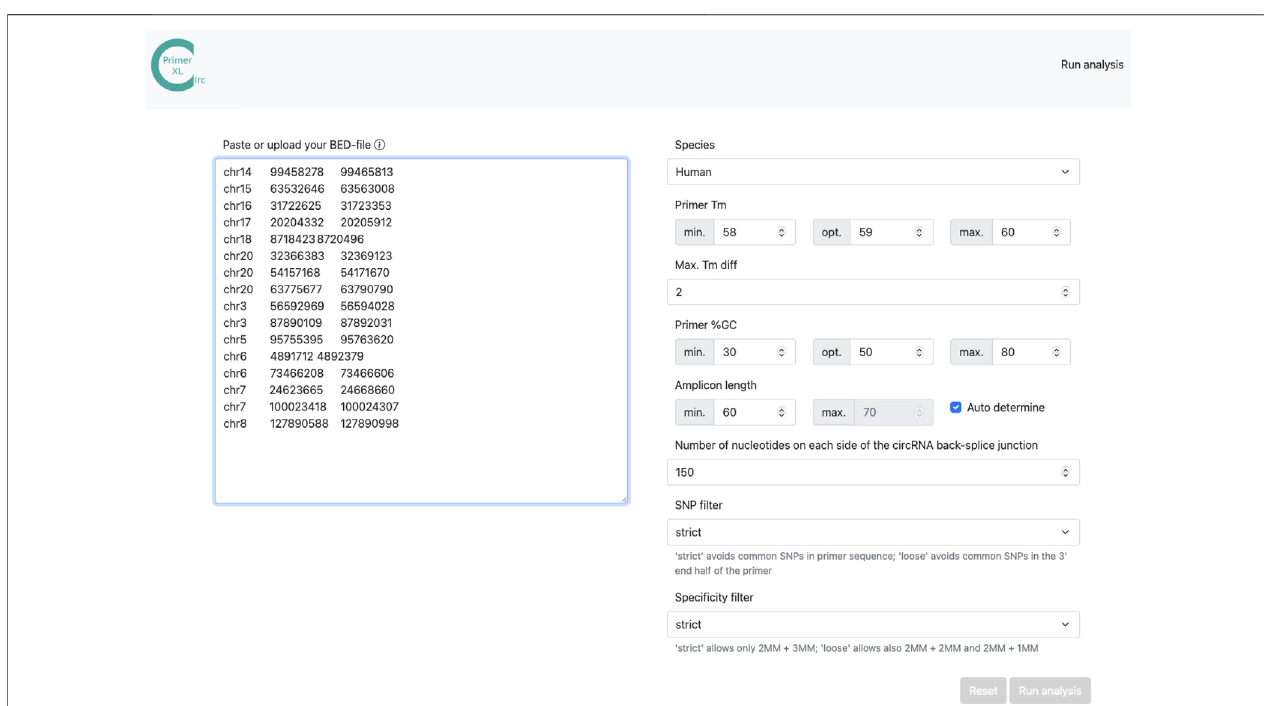
FIGURE 2 | CIRCprimerXL web interface. CIRCprimerXL is implemented as a user-friendly web-interface, where multiple parameters ( Table 2 ) can be adjusted.